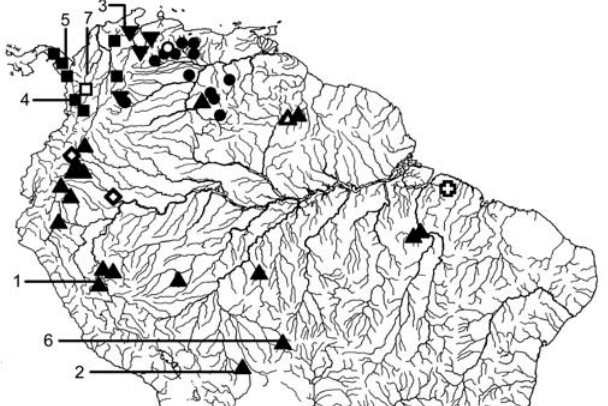
Fig. 3. Range of species of Lasiancistrus . Open symbols are type localities except for in L. heteracanthus where the type locality is not specific. Triangles = L. schomburgkii , squares = L. caucanus , upside down triangles = L. guacharote , dia- monds = L. heteracanthus , cross = L. saetiger , and circles = L. tentaculatus . The following are type localities for species in synonymy that have good locality information: 1.